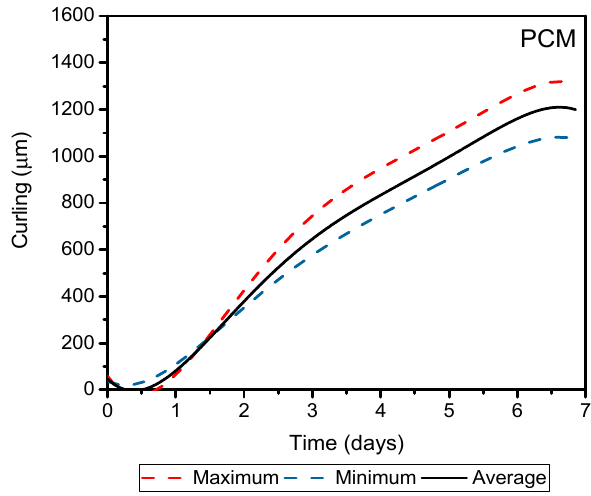
Figure 9. Curling over the time for Portland cement mortars screeds.